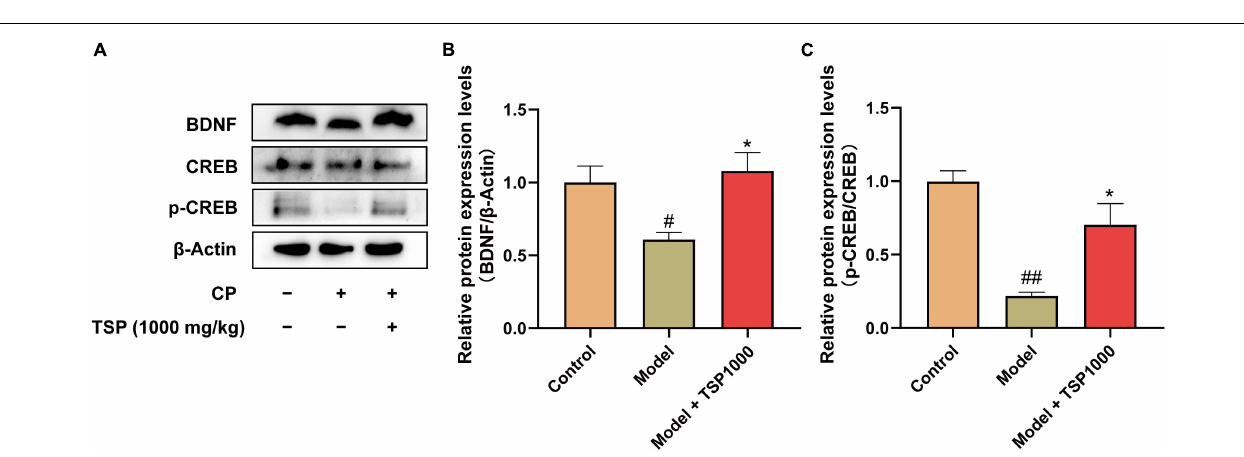
Frontiers in Nutrition |